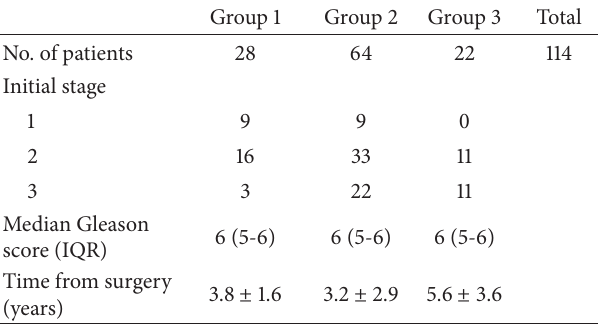
Table 1: Demographic details of the study